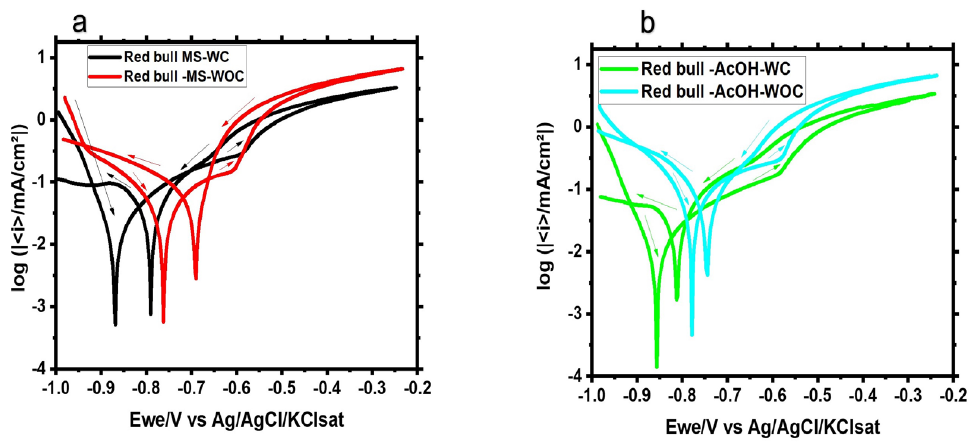
Figure 8. Cyclic potentiodynamic curves for the Red Bull samples with (WC) and without (WOC) an organic coating studied in ( a ) the main solution of the soft drink and ( b ) acetic acid; Ewe: working electrode